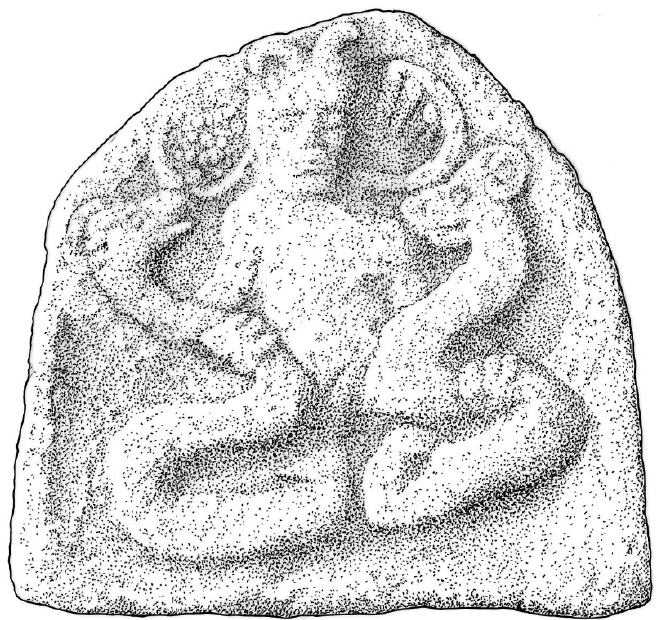
Figure 6. Romano-British limestone relief carving of a composite human/animal figure, with antlers and ram-headed snakes; from the Roman town of Corinium (Cirencester), Gloucester, UK. © Nick Griffiths.